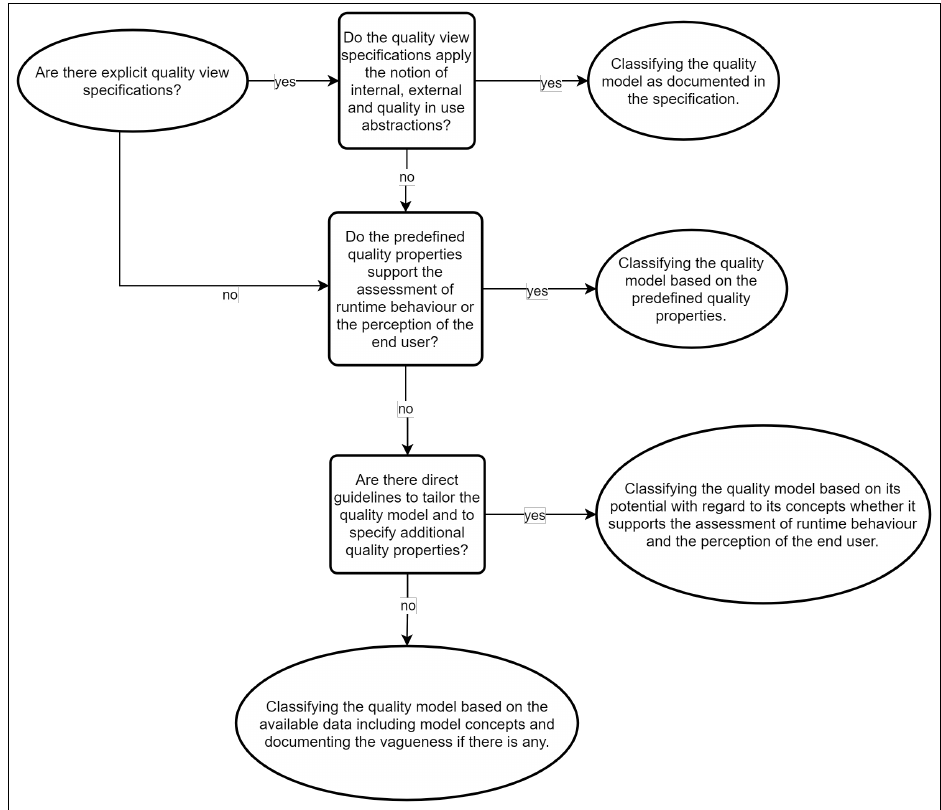
Figure 1. The flow chart of the quality model